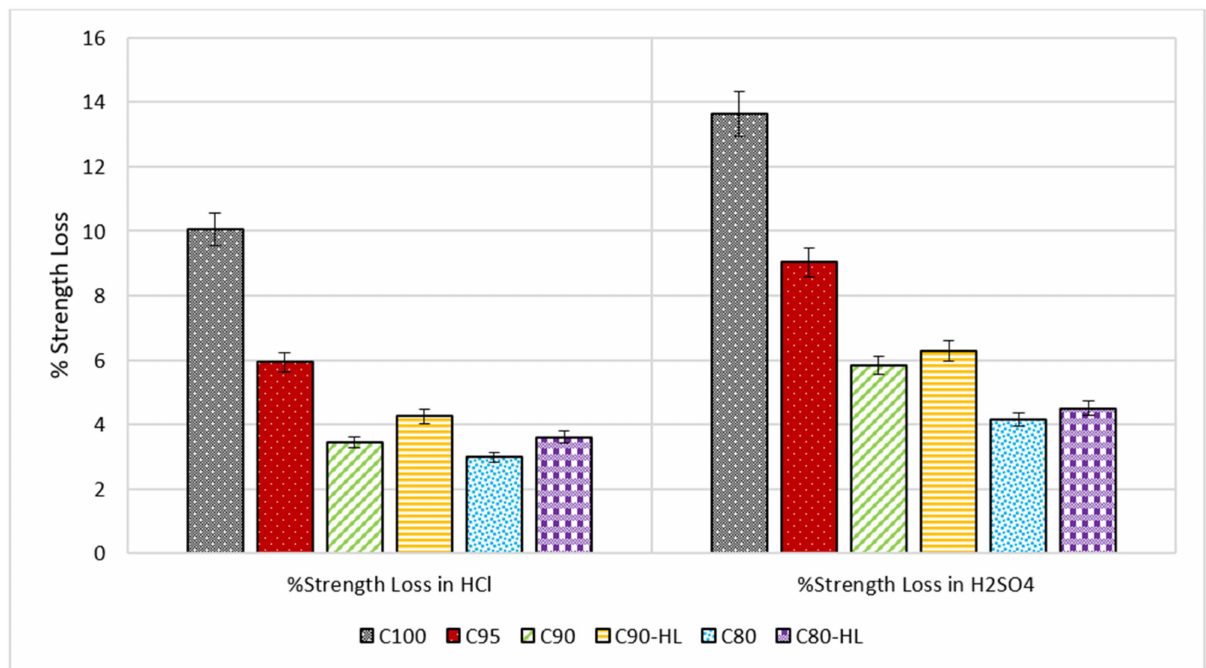
Figure 16. Percentage loss in compressive strength after exposure to the acidic environment.